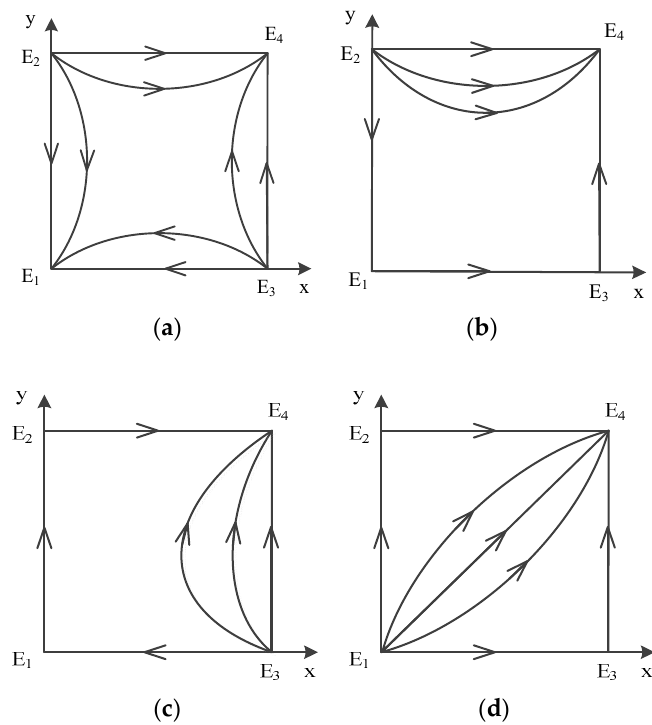
( ) 0,0 E , ( a ) Case 4 ( b ) Case 9 ( c ) 1